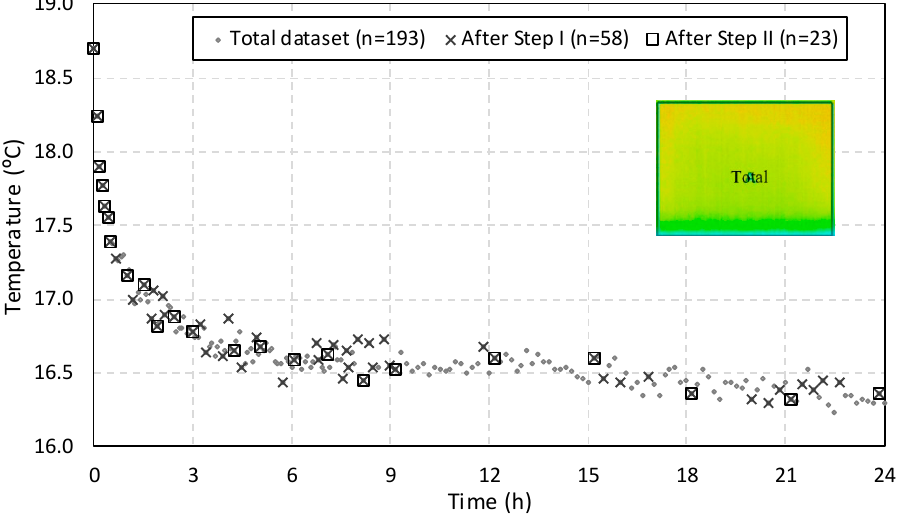
Figure 6. Sample reduction due to pre-processing phase.